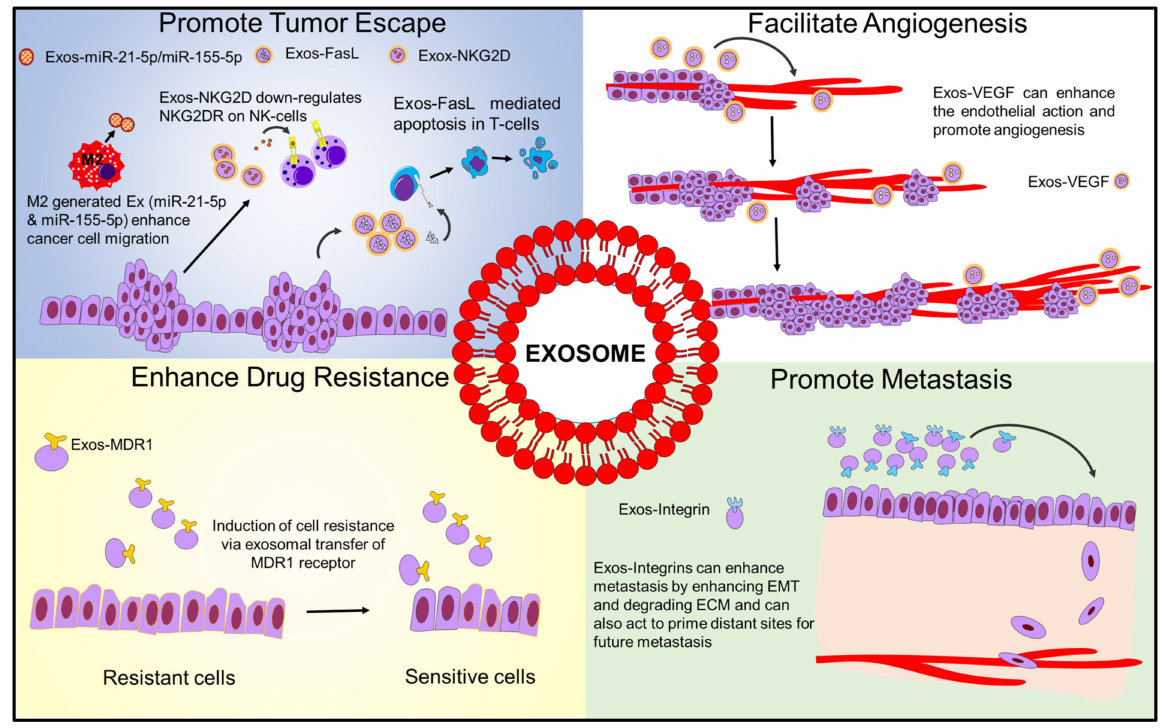
Figure 1. Schematic diagram showing how exosomes influence tumor